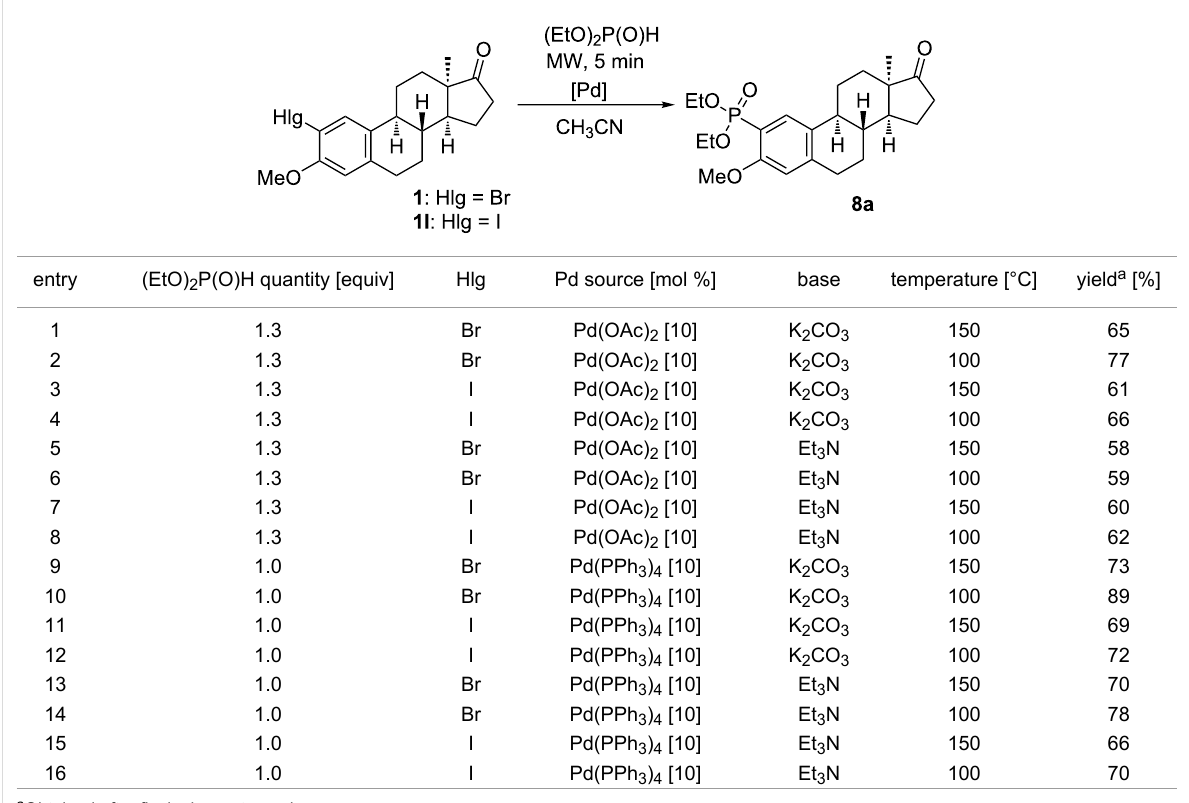
Table 1: Effect of the reaction conditions on Hirao reaction of 2-bromo- or 2-iodo-13 α -estrone 3-methyl ether ( 1 or 1I ) with diethyl phosphite ( 7a ).